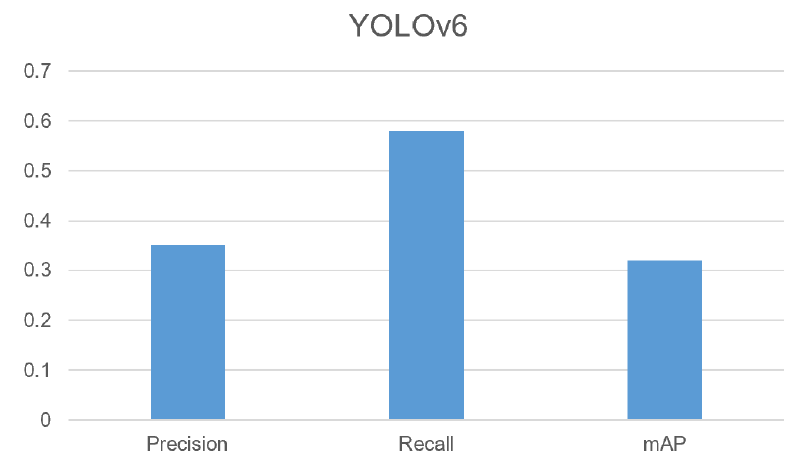
Figure 31. Comparison chart: Comparison between precision, recall, and mAP.